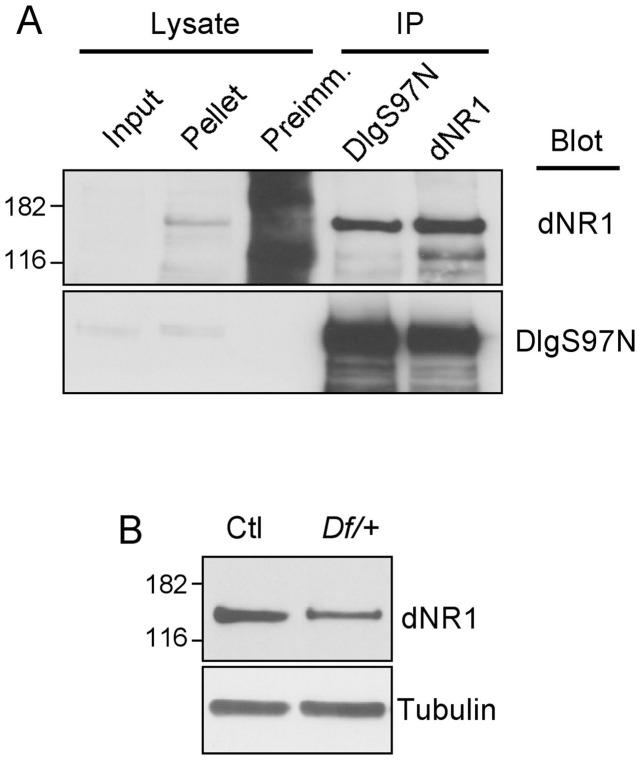
DlgS97 and NMDAR1 form a stable complex in vivo.(A) Immunoprecipitation of a complex containing dNR1 and DlgS97 from adult head extracts. Proteins were immunoprecipitated with pre-immune control (lane 2), anti-DlgS97 antibody (lane 3) and anti-dNR1 antibody (lane 4). Input lane represents 5% of the total lysates. (B) Western blot analysis of the anti-dNR1 antibody using control (lane 1) and dNR1 heterozygous deficiency NR190B.0 flies (lane 2).